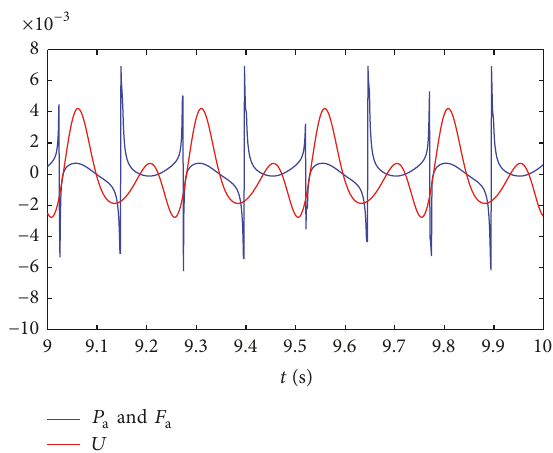
Figure 8: SDRE control signal to constant velocity ( 𝑥 2∗ = 8.415 rad/s = 10km/h) with double-cylinder excited by pressure (normalized).